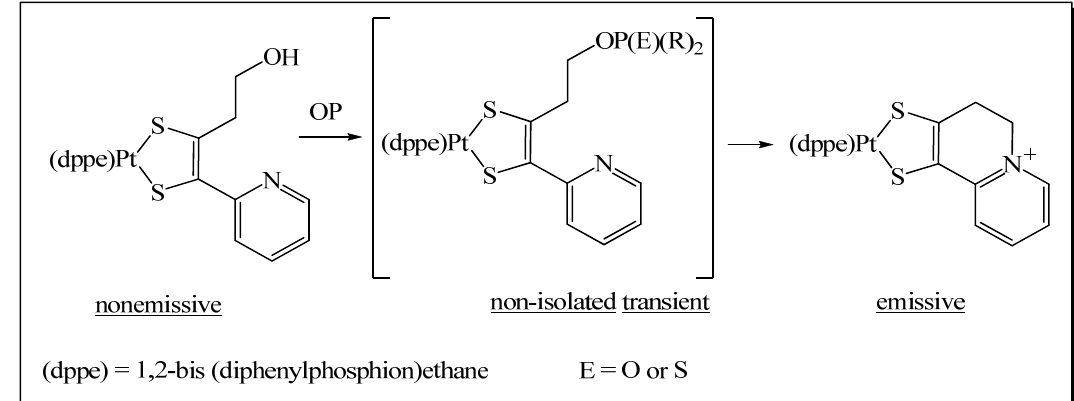
Figure 5. Mechanism of the chemically reactive sensor developed by Van Houten et al . Reproduced with permission from Reference [29], published by American Chemical Society, 1998.